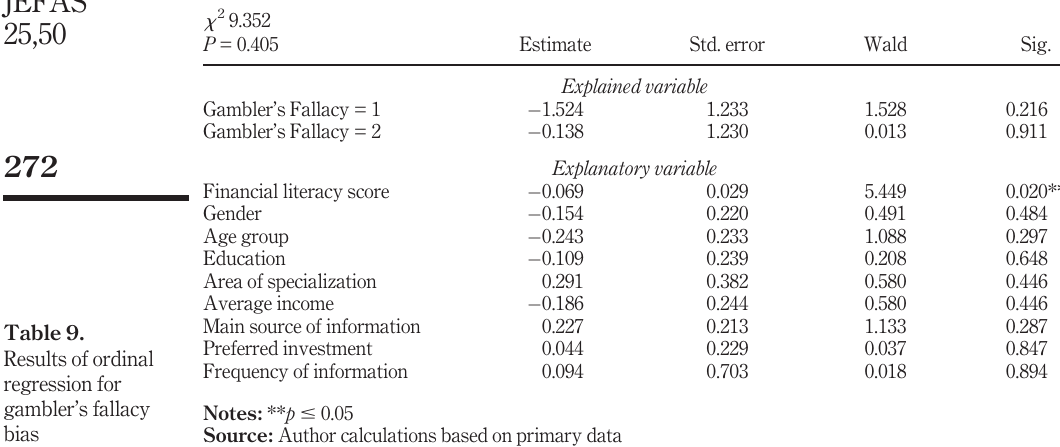
Table 9. Results of ordinal regression for gambler ’ s fallacy bias